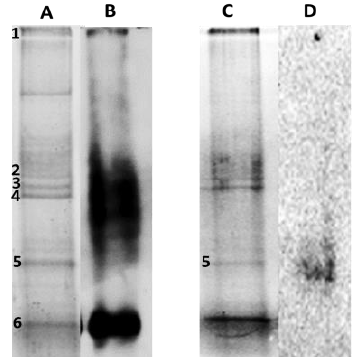
Figure 5. Carbonylated proteins profiles in leaves of P. fasciculatum . ( A ) and ( C ). Protein leaves of P. fasciculatum exposed Cd and Pb, electrophoresed at gel polyacrylamide staining with Coomassie brilliant blue. ( B ) and ( D ). Oxyblots of protein roots and leaves of P. fasciculatum exposed Cd and Pb.